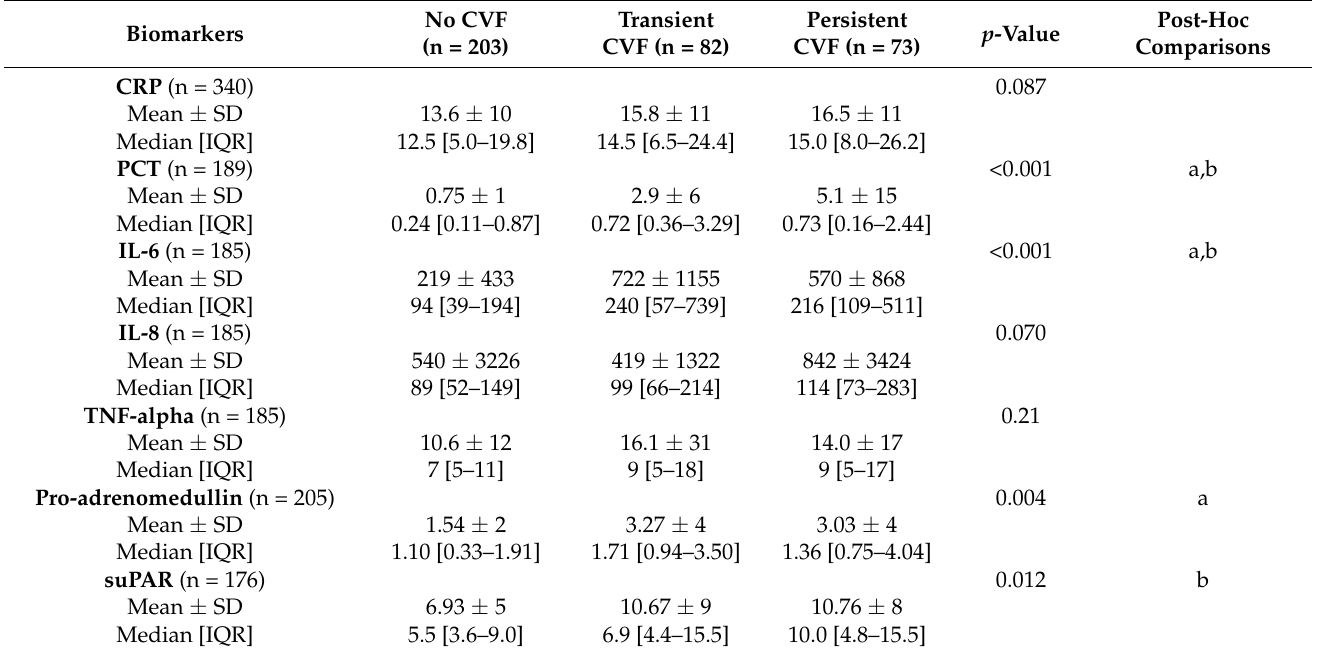
Table 3. Inflammatory response at pneumonia diagnosis.